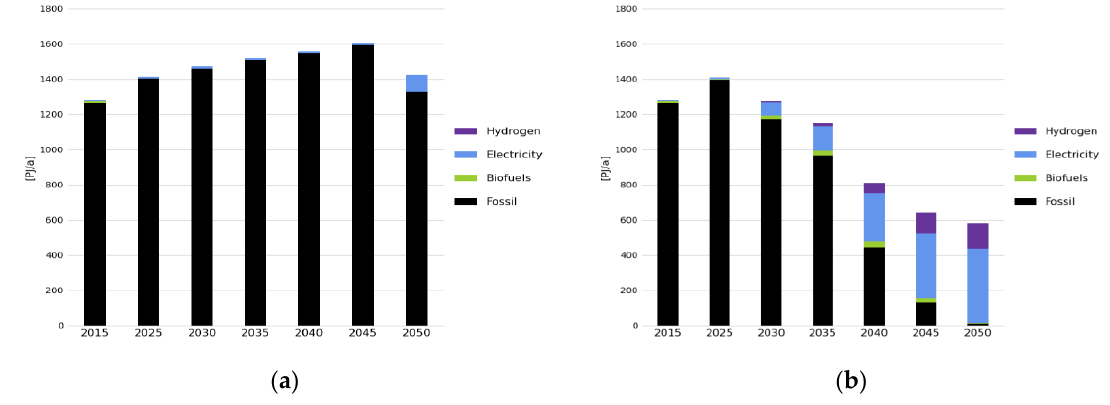
Figure 6. Australia’s transport energy use by fuel type and scenario: ( a ) LME; ( b ) P1.5